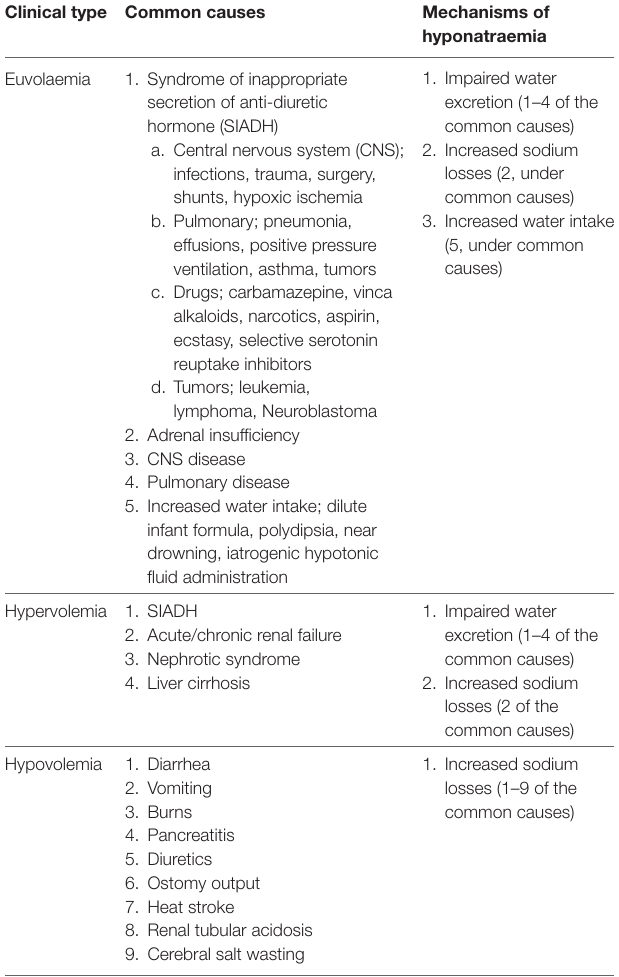
TABLe 5 | Other non-diarrheal causes, and clinical classes of hyponatraemia (16, 34,